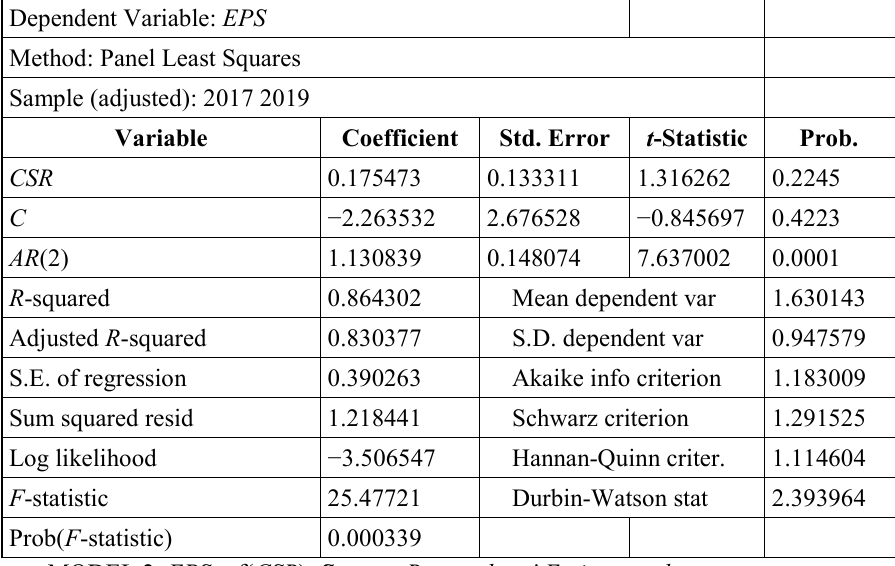
Table 6. Corporate Social Responsibility and Earnings per